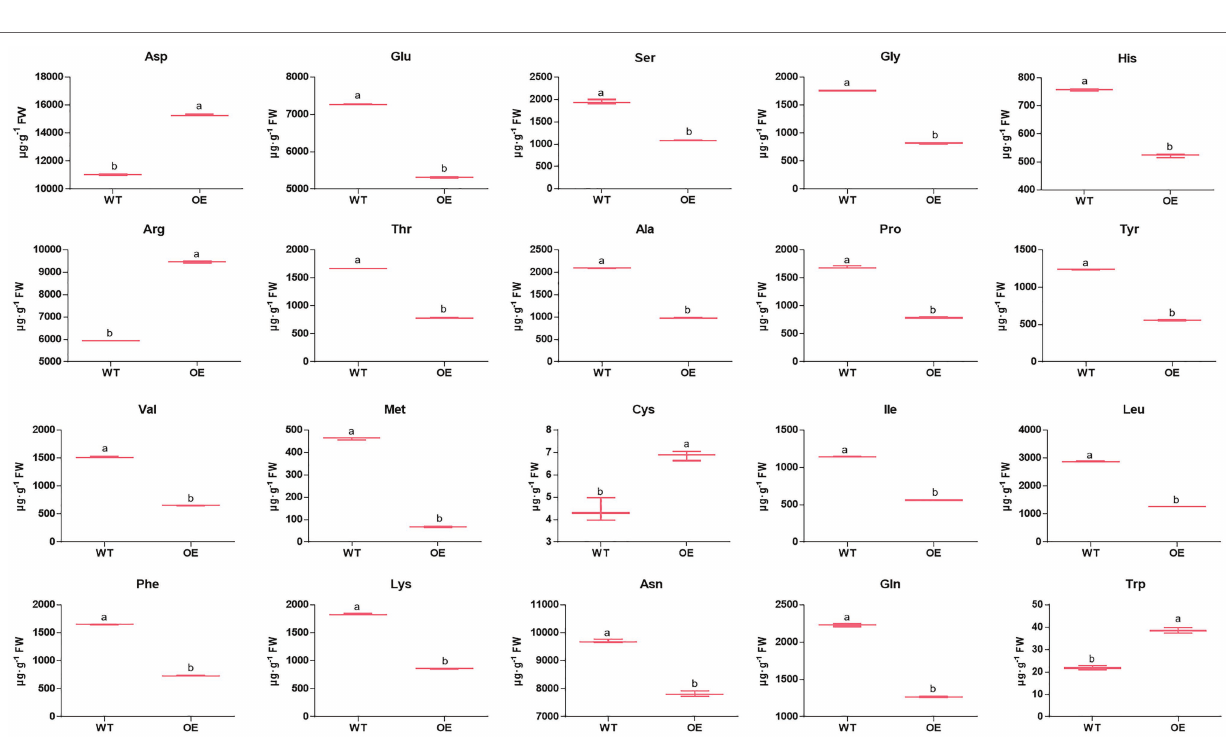
FIGURE 5 | Overexpression of PpEBB1 made great influence on amino acid content. Twenty types of amino acid content are found in the basal portions of the shoots in WT and PpEBB1-oe poplar. The values represent the means ± SDs of three replicates. Letters indicate significant differences by ANOVA followed by Duncan’s test ( p <